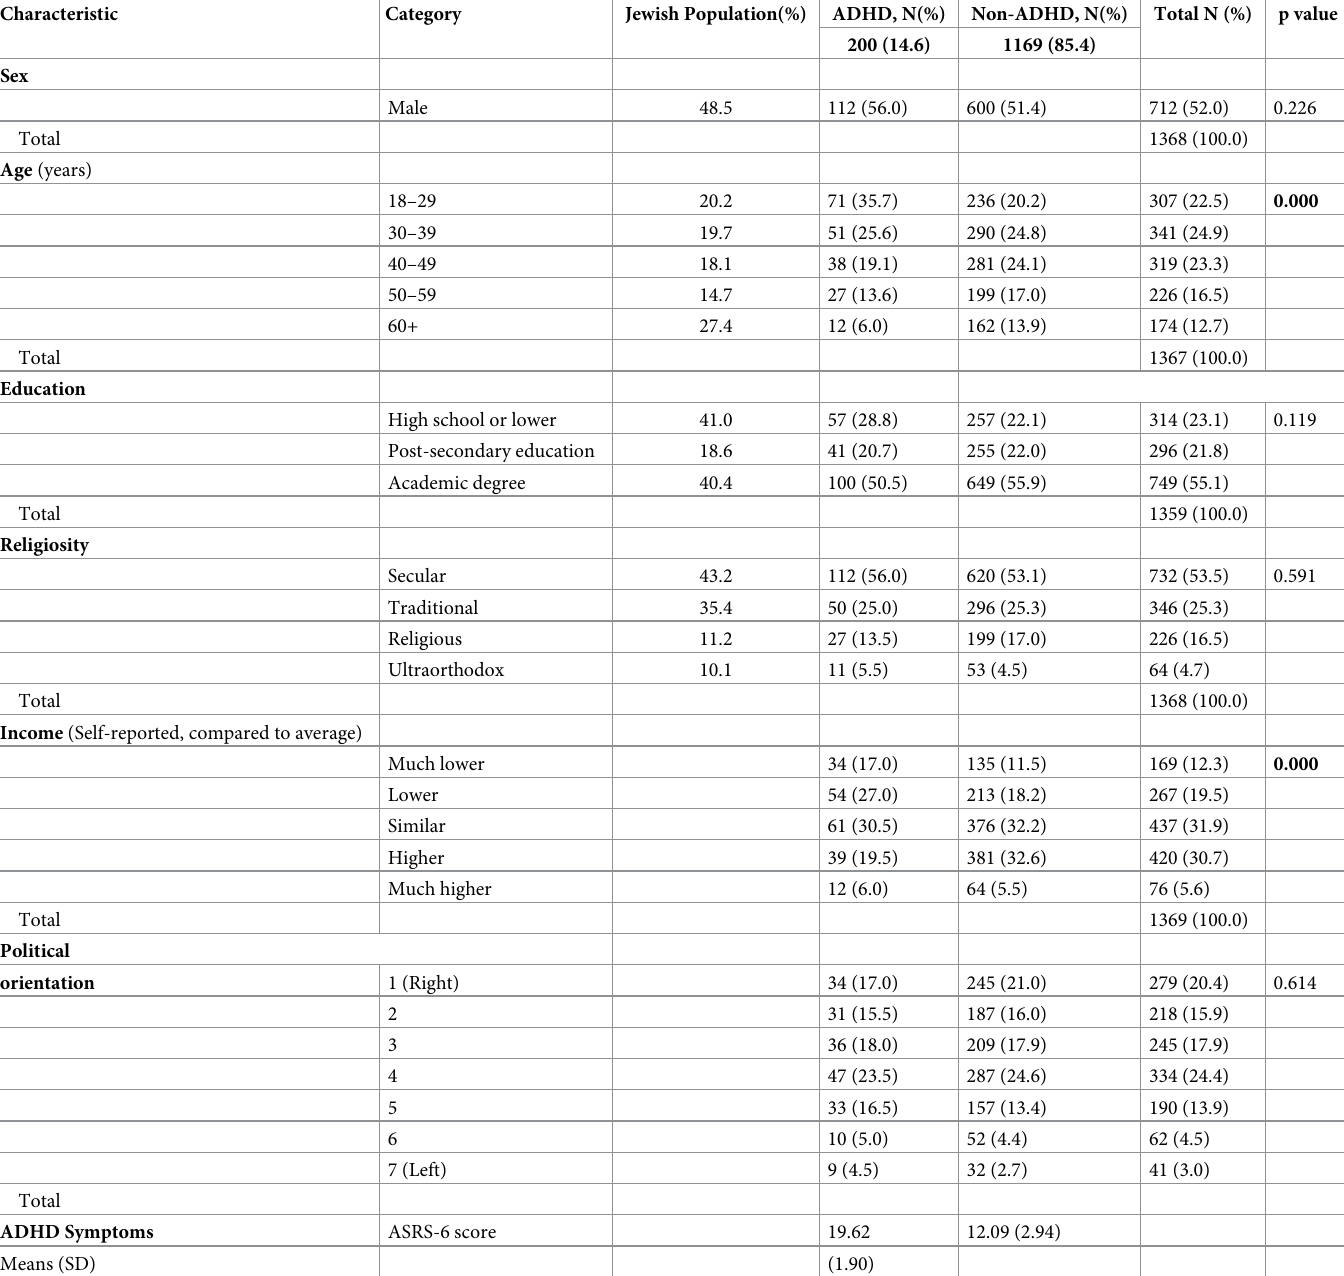
Table 1. Characteristics of the study